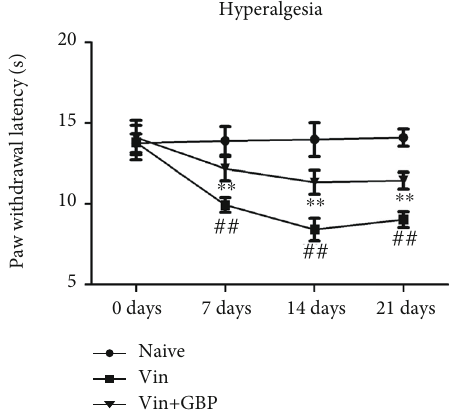
Figure 3: G. elata polysaccharide (GBP) treatment relieves pain hypersensitivity in vincristine-induced neuropathic pain rats. Paw withdrawal latency in di ff erent groups. Data were expressed as the mean ± SD ( n = 8 for each group). # P < 0 : 01 : vs. naive group; ∗∗ P < 0 : 01 : vs. Vin group. Two-way ANOVA followed by Bonferroni ’ s post hoc analysis.